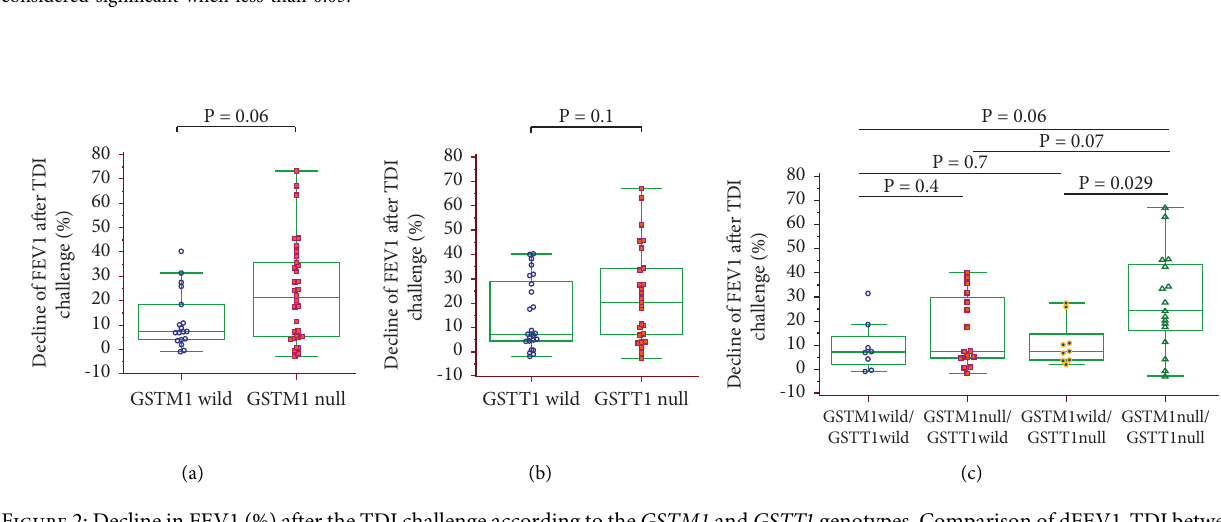
Figure 2: Decline in FEV1 (%) after the TDI challenge according to the GSTM1 and GSTT1 genotypes. Comparison of dFEV1-TDI between the GSTM1 null and wild-type genotypes (a), between the GSTT1 null and wild-type genotypes (b), and among the combined GSTM1 and GSTT1 genotypes